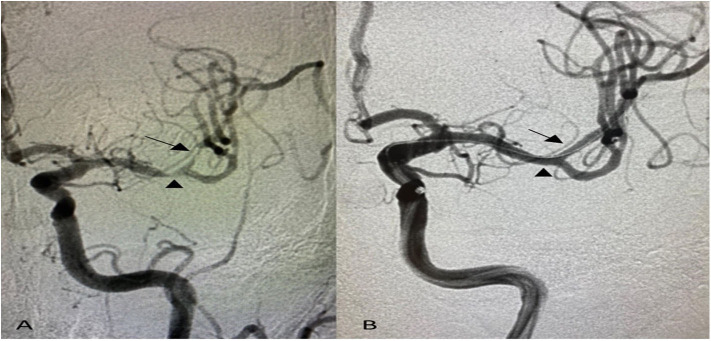
Anterior–posterior projection of digital subtraction angiography shows (A) tandem intracranial significant stenoses of the left middle cerebral artery; distal M1 segment (arrowhead) and superior division of M2 segment (arrow), (B) post-angioplasty and stenting with no residual stenosis using 2 Resolute Onyx Drug-Eluting Stents 2 × 8 mm.